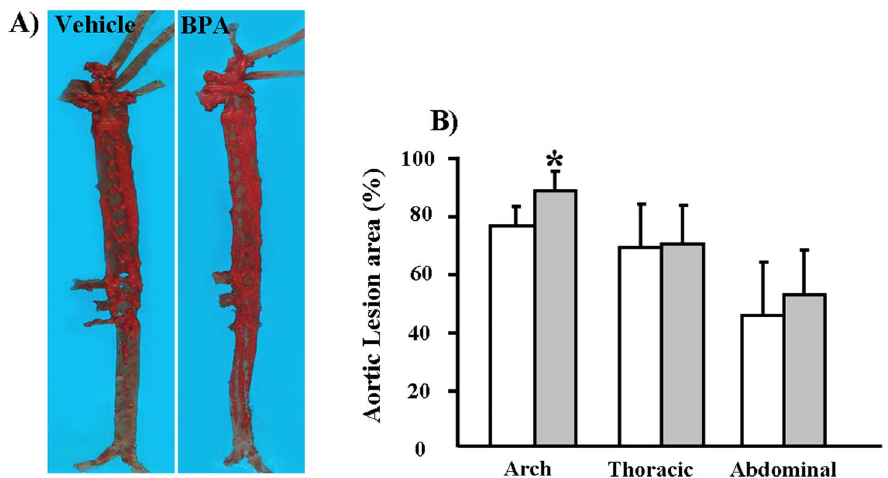
Figure 4. Quantitative analysis of aortic atherosclerosis in WHHL rabbits at 12 weeks. (A) Representative micrographs of the aortic trees stained with Sudan IV. (B) The sudanophilic en-face lesion areas in different parts of aortic trees were determined using an image analysis system as described in the Materials and Methods section. Data are expressed as the means 6 SD, n=6 for each group. * p , 0.05 vs. vehicle. doi:10.1371/journal.pone.0110977.g004 relative quantification, and the relative amount of mRNA was calculated using the 2 2 DD CT method [33]. The primers used in this experiment are shown in Table S1.